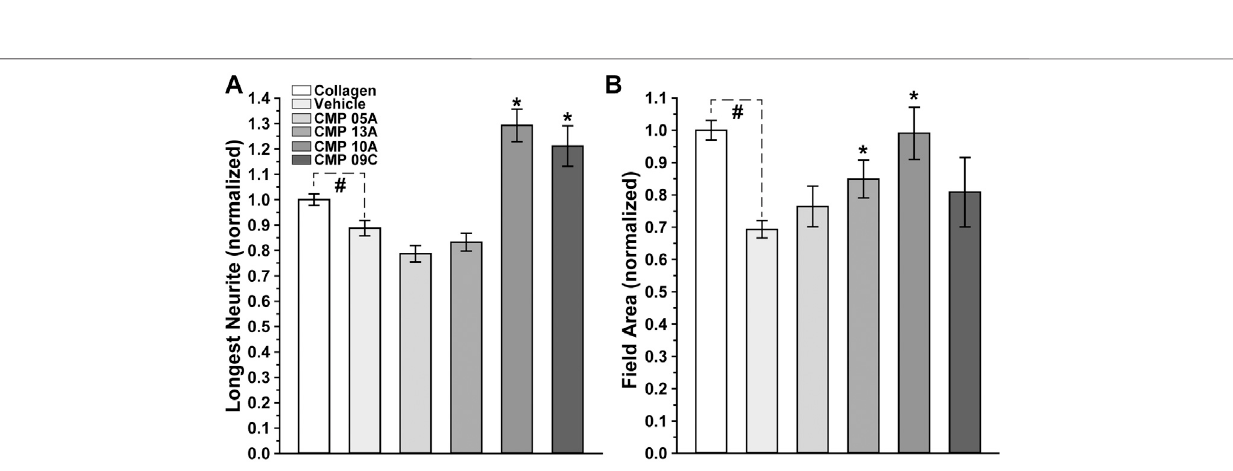
Frontiers in Pharmacology |